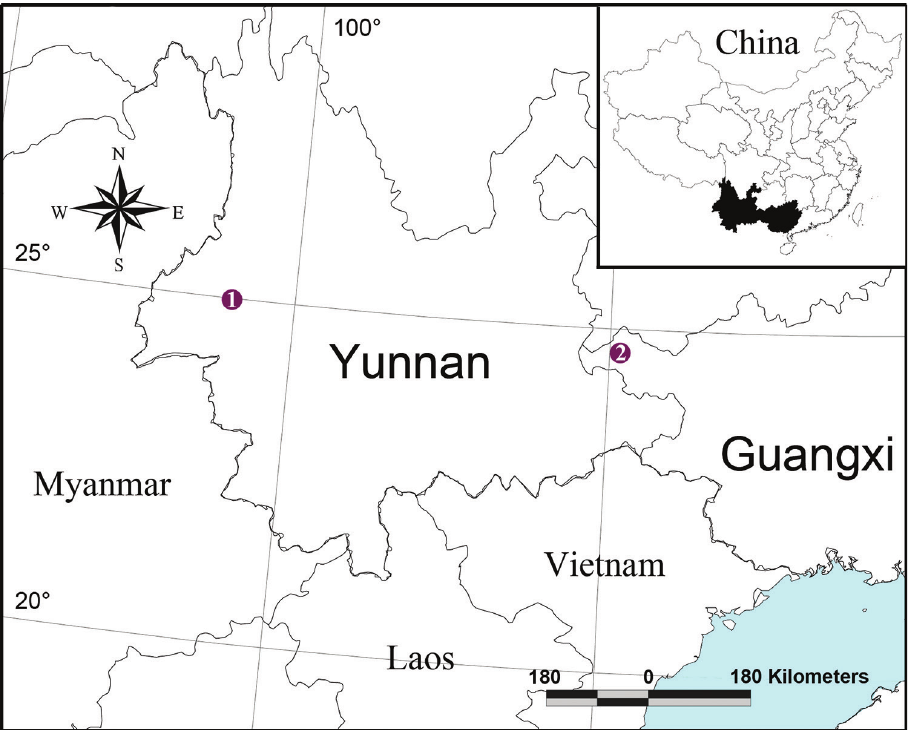
Figure 9. Type localities of new species Callosa ciliata sp. n. ( 1 ) and C. baiseensis sp. n. ( 2